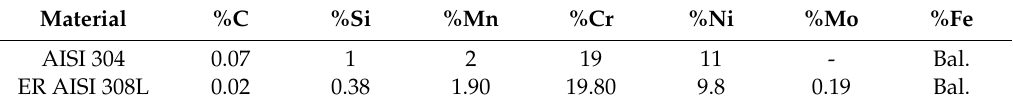
Table 1. Chemical composition of AISI 304 and ER AISI 308 L base and filler stainless steels.